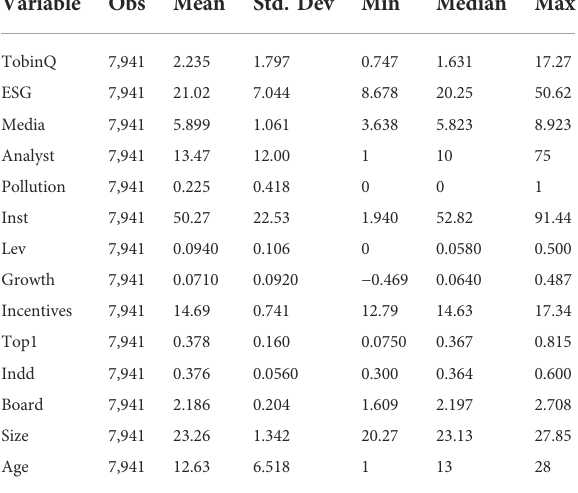
TABLE 2 Descriptive statistics of